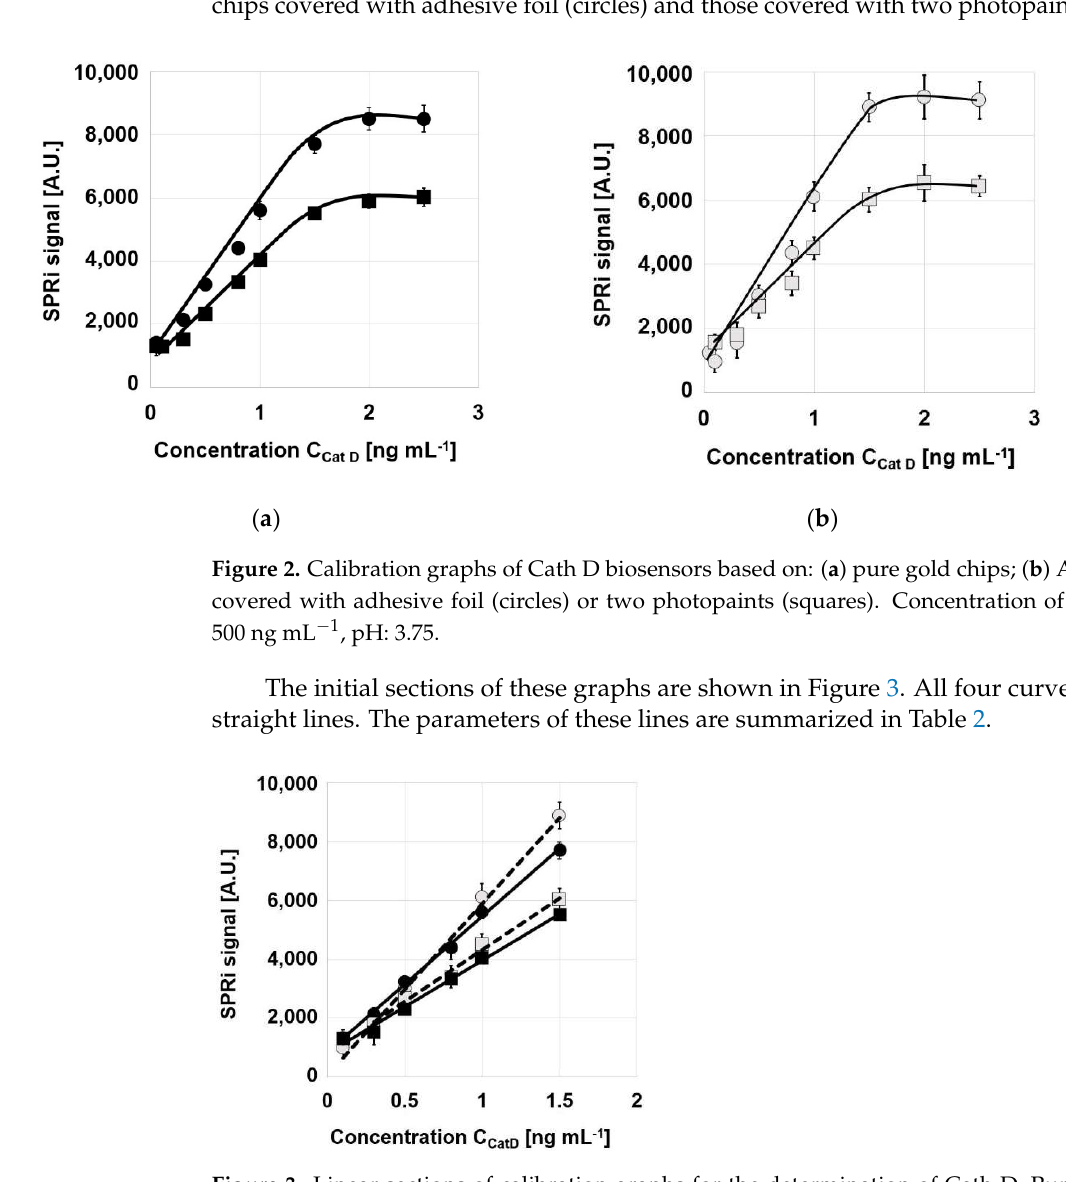
Figure 3. Linear sections of calibration graphs for the determination of Cath D. Pure gold chips, squares; Ag/Au chips, circles; black points, two paints; open points, adhesive foil. Concentration of pepstatin A: 500 ng mL −1 , pH: 3.75.